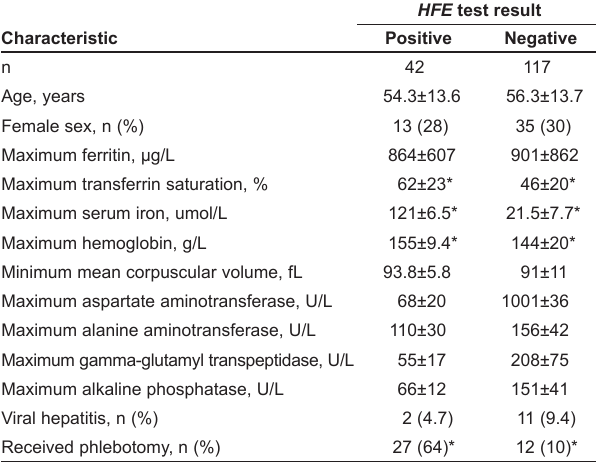
TABle 1 Genetic testing results HFE genotype